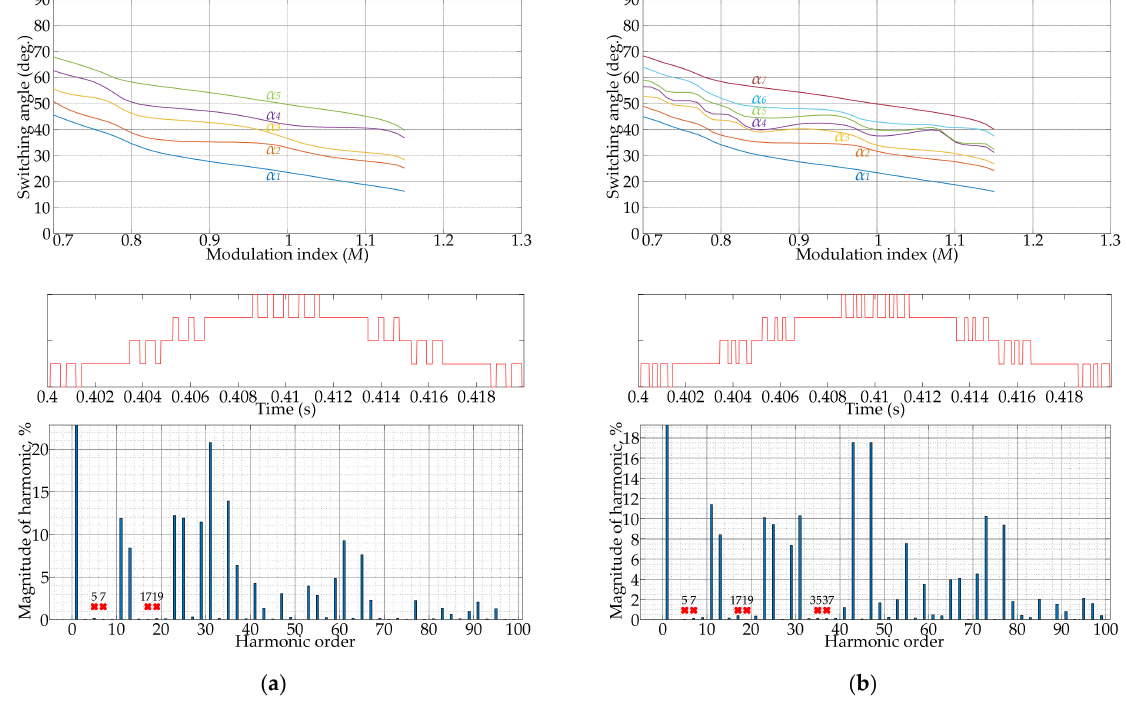
Figure 10. Results of solution trajectories, PPWM waveforms and FFT spectra for eighteen-pulse connection scheme based on fsolve function: ( a ) SHE problem with five switching angles; ( b ) SHE problem with seven switching